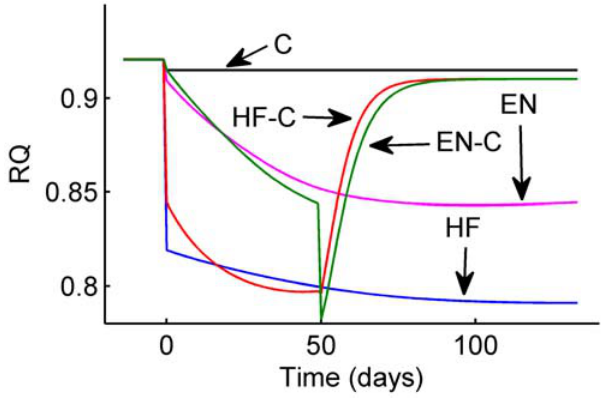
Figure 3. Model predictions for the daily respiratory quotient (RQ). The C group was fed a chow diet (black), the HF group was fed a high fat diet (blue), the EN group was fed a high fat diet plus Ensure (pink), the HF-C group was fed a high fat diet for 7 wk followed by a switch to chow (red), and the EN-C group was fed a high fat diet plus Ensure for 7 wk followed by a switch to chow